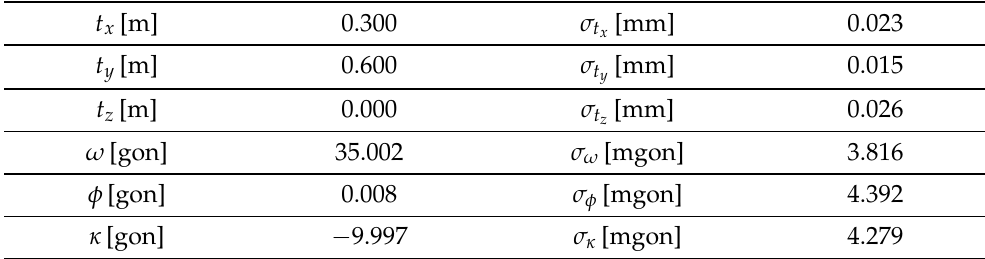
Table 3. Results of the estimated rigid body movement (data set V0)